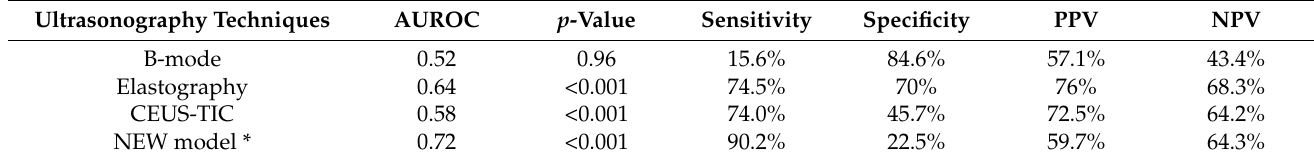
Table 4. Ultrasonography-based performance at differentiating benign vs. malign